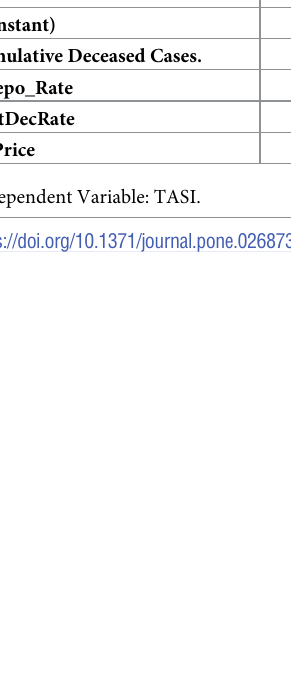
Table 18. Coefficients of TASI model with control variable.